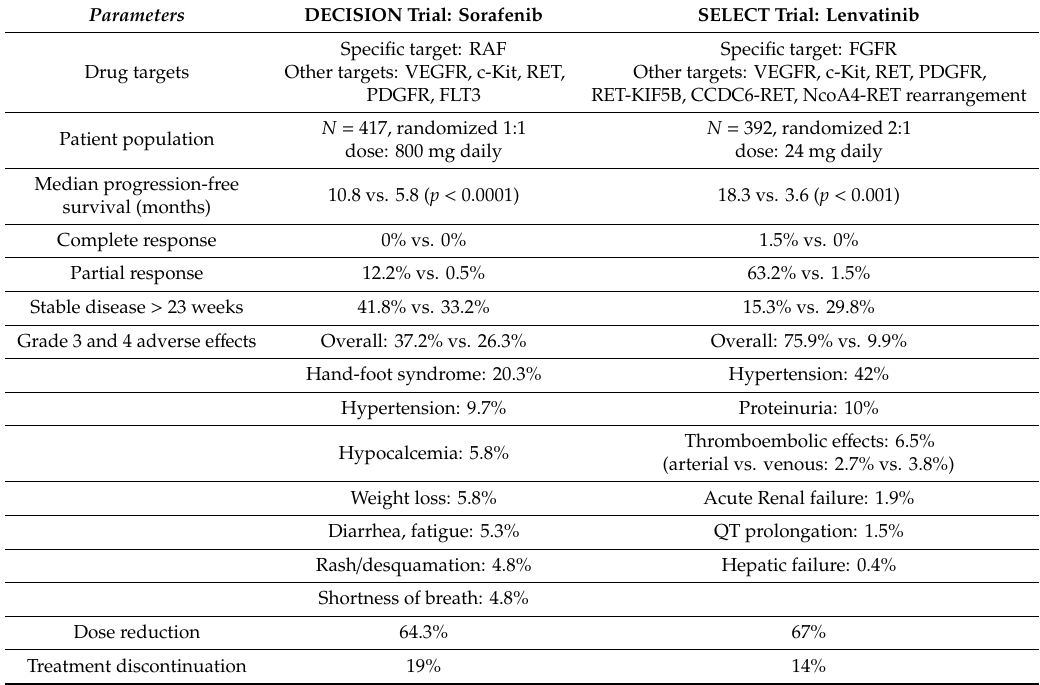
Table 1. Completed Phase III Clinical Trials of Agents Approved for the Treatment of Di ff erentiated Thyroid Cancer by the U.S. Food and Drug Administration